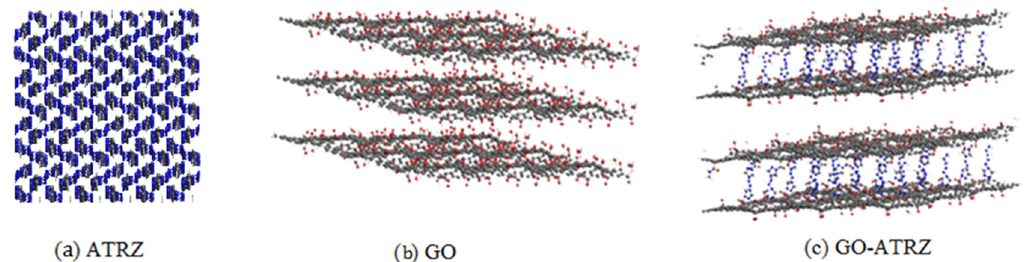
Figure 11. Molecule structure of 4,4 (cid:48) -azo 1,2,4-triazole ( a ), GO ( b ), and GO-4,4 (cid:48) -azo 1,2,4-triazole ( c ). Reprinted from ref. Figure 12. Molecule structure of 4,4 ′ -azo 1,2,4-triazole ( a ), GO ( b ), and GO-4,4 ′ -azo 1,2,4-triazole ( c ).